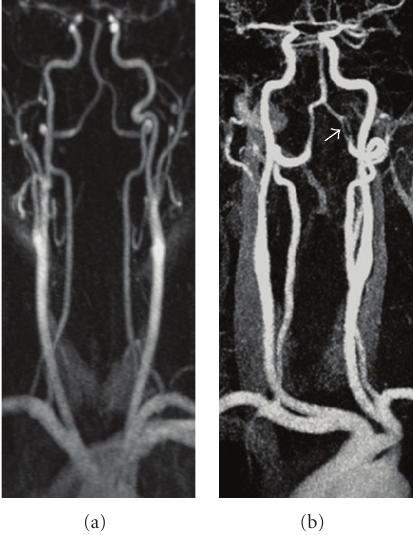
Figure 4: Comparison of a standard high temporal and low spa- tial resolution TWIST-MRA (a) and a high spatial resolution TWIST MRA (b) in two di ff erent patients. Due to the lower spatial resolution the vessels in (a) appear blurred and vascular anomalies like stenosis or fenestration (e.g., arrow in b) might be missed.